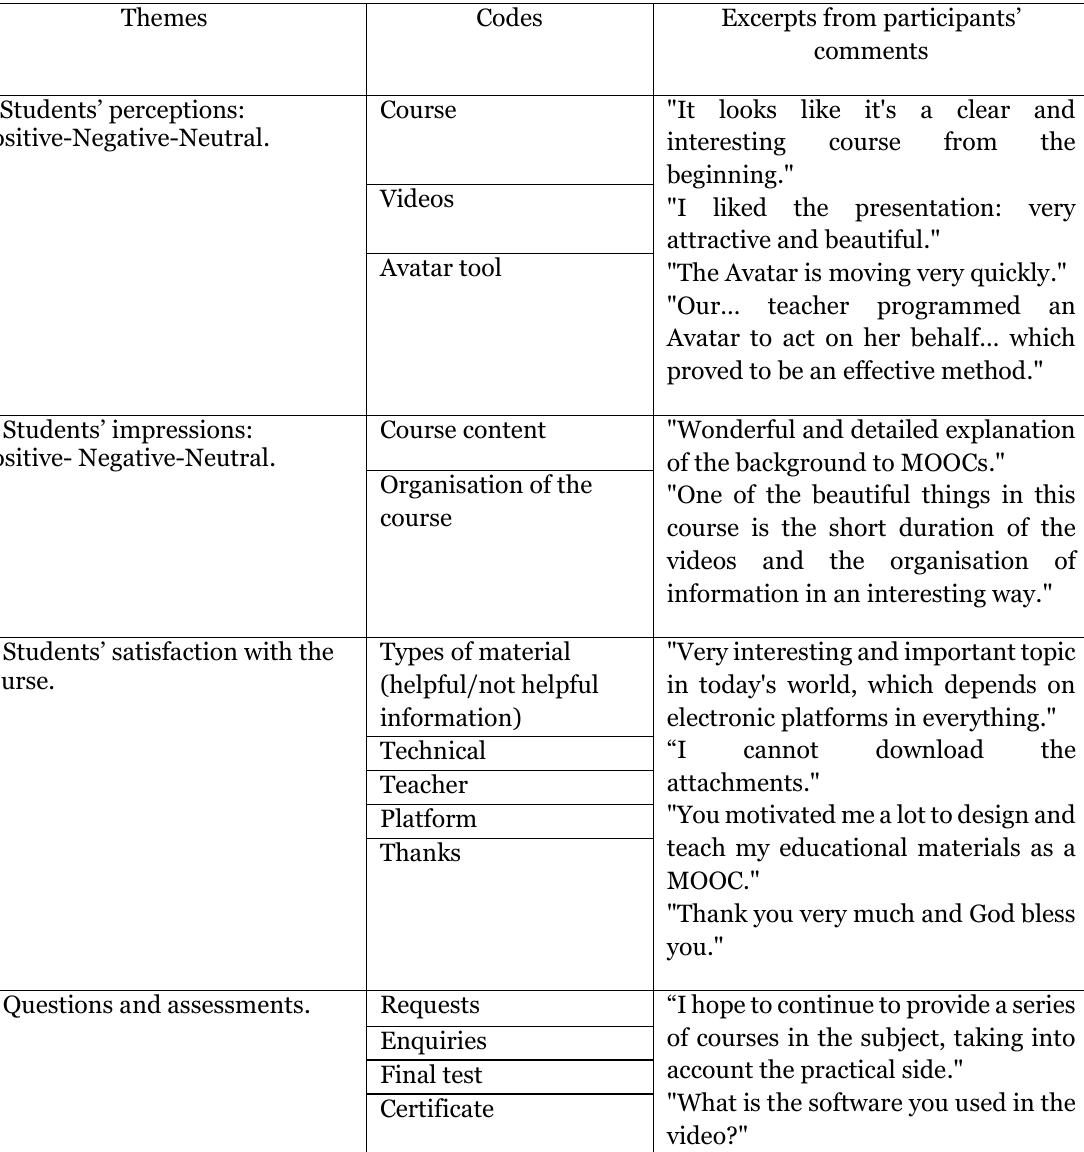
Thematic Analysis of Participants'